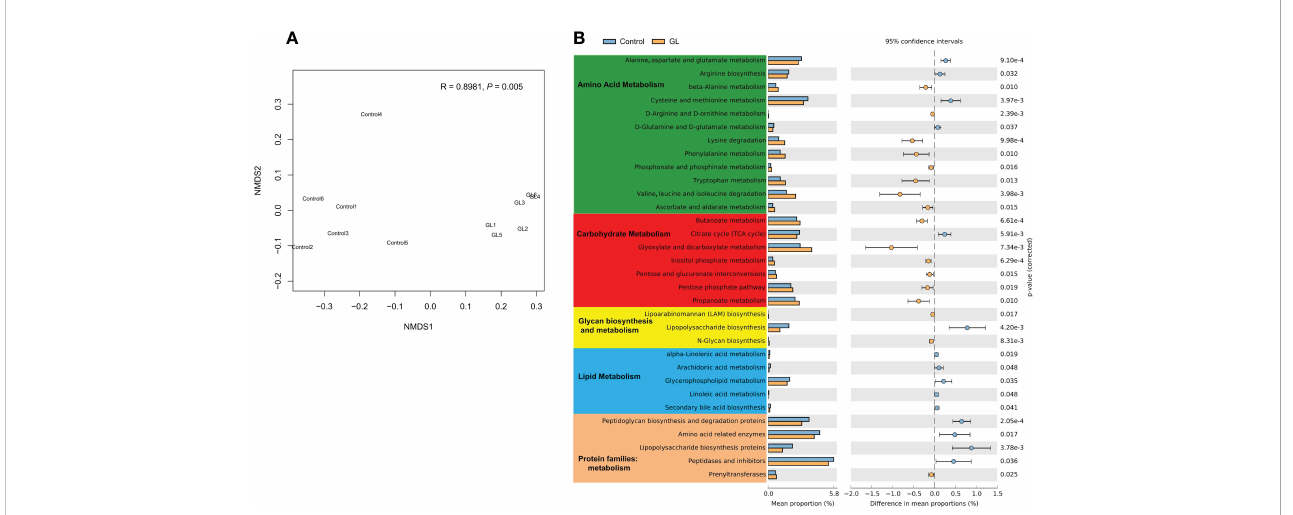
FIGURE 3 The effects of b -1,3-glucan on the microbial function. (A) NMDS plot visualizing microbial function dissimilarities using Bray – Curtis distance at KO level, and the test of difference was calculated by analysis of similarity (ANOSIM); (B) A two-sided Welch ’ s t test analysis of the microbial metabolic function using the response ratio method at a 95% con fi dence interval (CI).